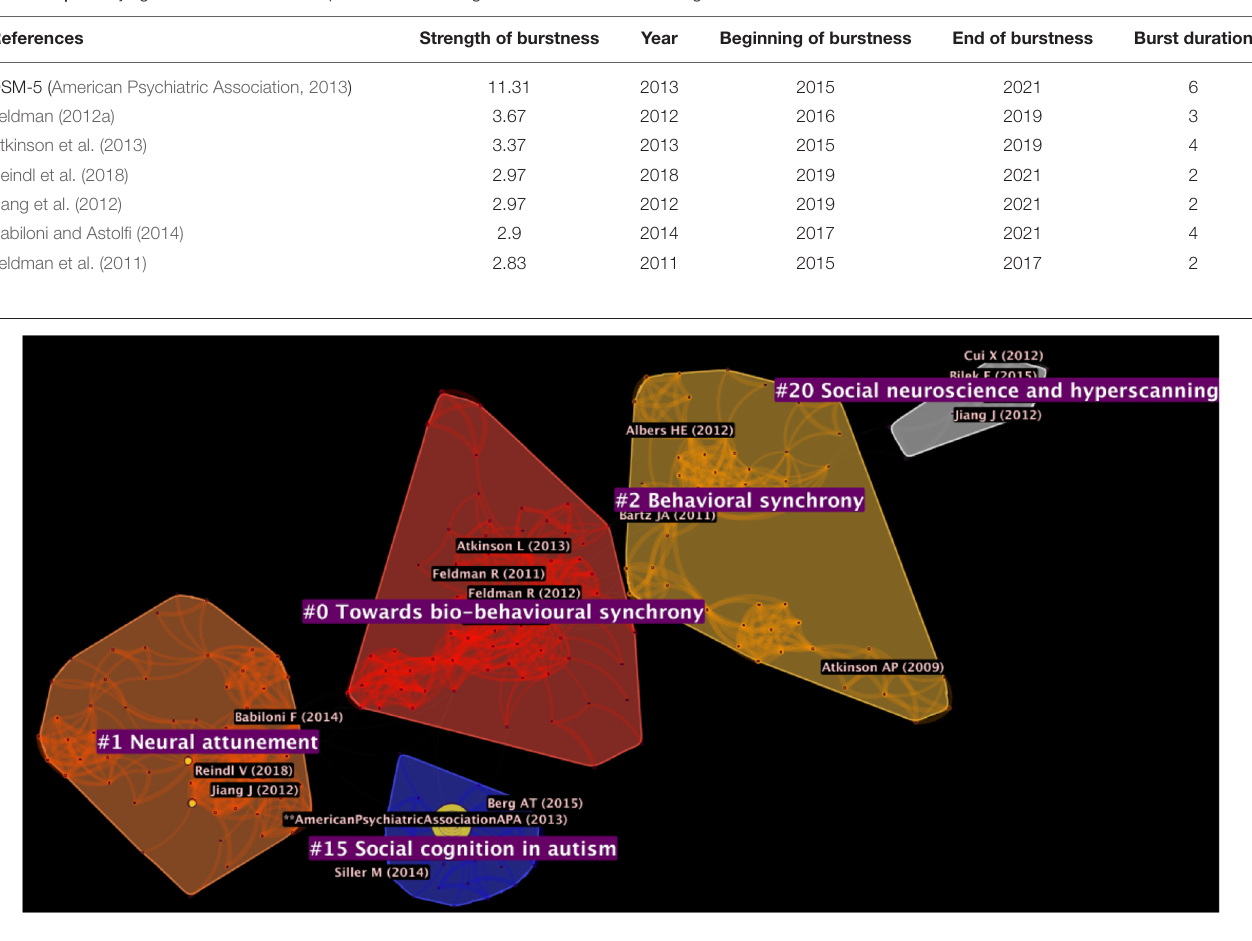
FIGURE 2 | Network of publications generated through the